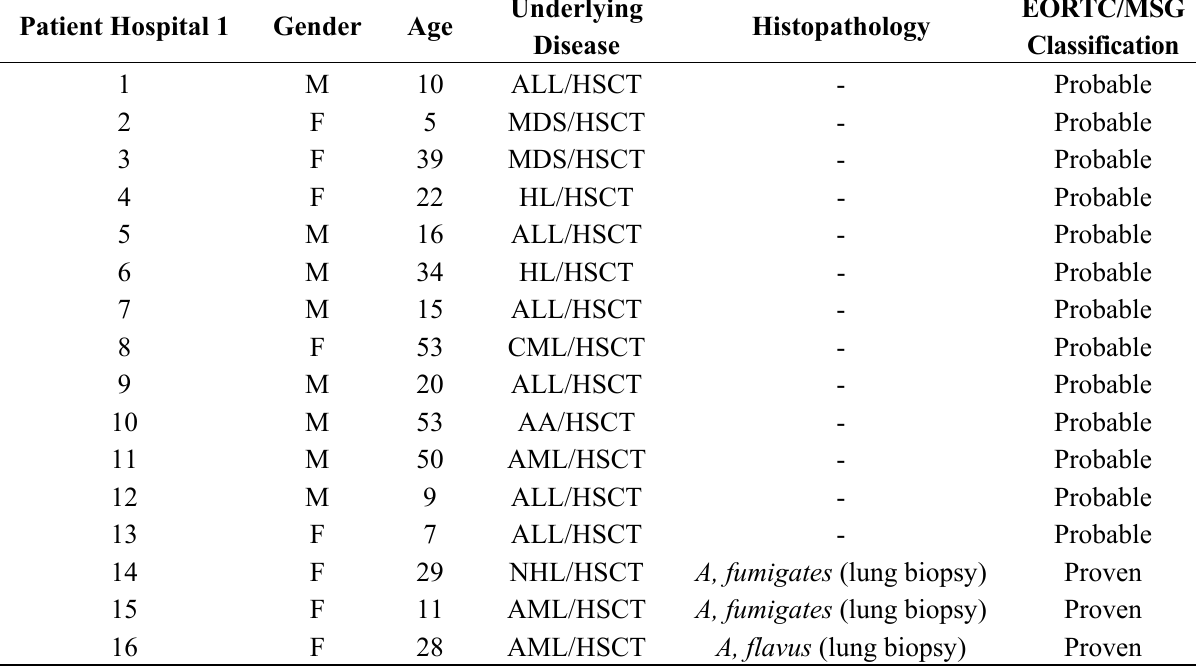
Table 5. The serum samples were pooled for the immunoproteome assays as follows: proven/hospital 1, proven/hospital 2, probable or other-mycosis. Table 4. Additional information about patients from Hospital